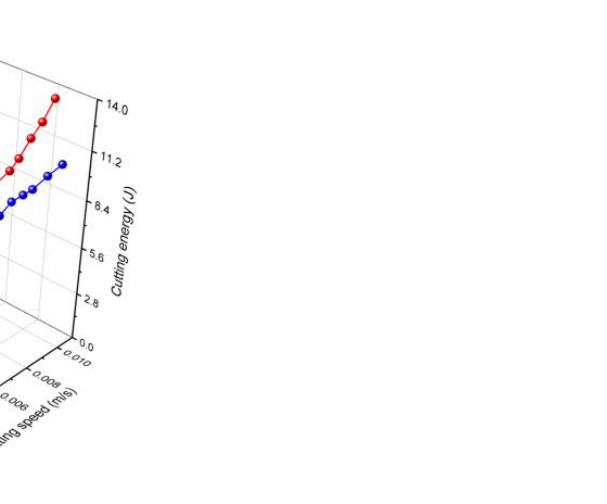
Figure 9. Variation in cutting energy for peeled and unpeeled parsnip with different humidity levels as a function of cutting speed.